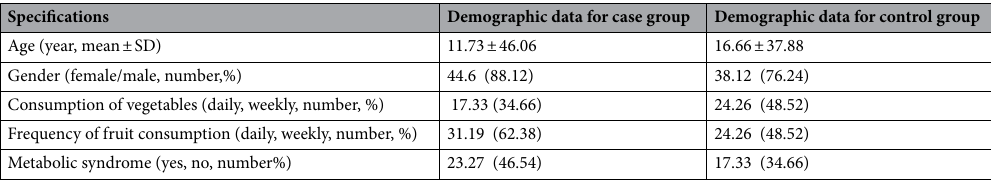
Table 1. Characteristics of the participants.